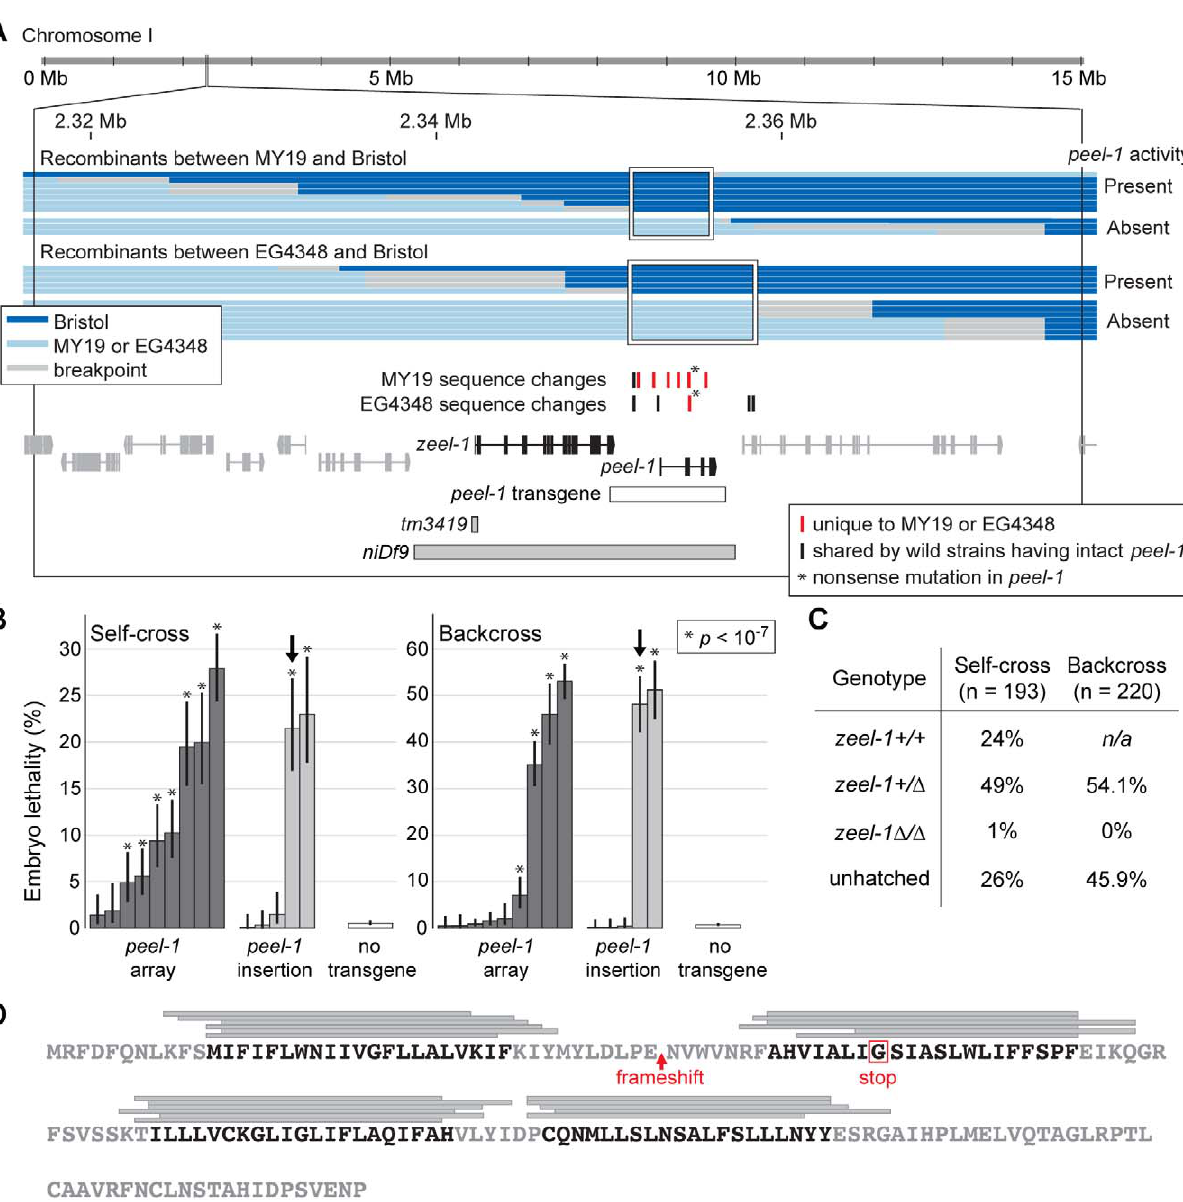
Figure 1. peel-1 is located adjacent to zeel-1 and encodes a four-pass transmembrane protein. (A) The large black box outlines the genomic region to which peel-1 was mapped previously [13]. Horizontal bars represent the recombinants used to map the peel-1 mutations in strains MY19 and EG4348. The maximum intervals defined by these mapping experiments are outlined by white boxes. Adjoining breakpoints are excluded because they contain no sequence changes relative to Bristol. Below the recombinants, tick marks indicate all sequence changes in MY19 or EG4348 located within the boxed intervals. Horizontal bars represent the peel-1 transgene, the zeel-1(tm3419) deletion allele, and the deficiency, niDf9 . niDf9 is carried by the Hawaii strain and by all other wild isolates lacking the activities of both peel-1 and zeel-1 [13]. (B) The Bristol allele of the peel-1 transgene shown in (A) was tested for its ability to restore peel-1 activity to animals carrying the peel-1 nonsense mutation found in EG4348. To test for peel-1 activity, transgenic animals were crossed to the Hawaii strain, and embryo lethality was scored from self-fertilizing F1 hermaphrodites (self- cross) and F1 males backcrossed to Hawaii hermaphrodites (backcross). Nine independent extra-chromosomal arrays and five independent single- copy genomic insertions were tested. For each array or insertion, 200 to 650 embryos were scored per self-cross or backcross. Ten control replicates were performed in parallel, each including 200 to 400 embryos. The global mean of these replicates is shown by the ‘‘no transgene’’ bars, and lethality for each individual replicate was less than 1.5%. Error bars indicate 95% binomial confidence intervals, calculated using the Agresti-Coull method [77]. * p , 10 2 7 , one-tailed binomial test relative to the mean of the control replicates. The observed variability among extra-chromosomal arrays was expected because of germline silencing [30]. The three single-copy insertions showing no peel-1 activity probably represent incomplete insertion events, which are a common outcome of the MosSCI method [59]. Arrows indicate the insertion used for further analysis in (C). (C) To confirm that the lethality observed in (B) was limited to zeel-1( D ) embryos, an additional self-cross and backcross were performed using the insertion marked in (B). All hatched progeny were genotyped at zeel-1 . In both crosses, the genotype frequencies among surviving progeny differed significantly from their Mendelian expectations ( x 2 tests, p , 10 2 9 ). n/a , not applicable. (D) The amino acid sequence of PEEL-1. Grey bars indicate predicted transmembrane helices, as predicted by (from top to bottom): TopPred [71], Tmpred [72], TMHMM [73], SOSUI [74], PHDhtm [75], and HMMTOP [76]. Regions predicted by at least four algorithms are highlighted in black. The frameshift in MY19 and the stop codon in EG4348 are indicated in red. doi:10.1371/journal.pbio.1001115.g001 PLoS Biology |